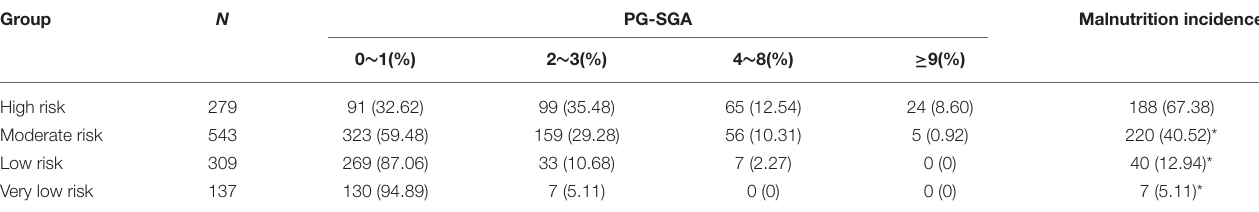
TABLE 3 | The relationship between risk classification and incidence of nutritional risk in newly diagnosed GIST patients ( N = 1,268) [n(%)].